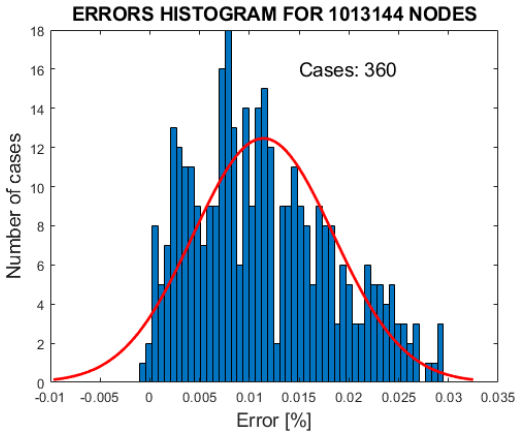
Figure 5. Errors histogram for FEMM vs. analytical solution, mesh with 1,013,144 nodes.